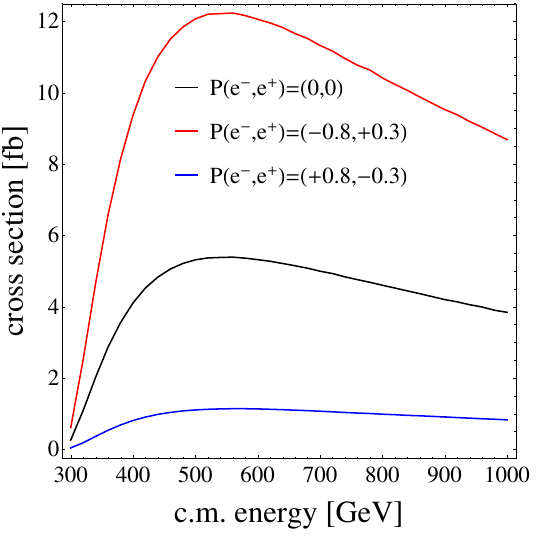
Figure 2 . Cross section of the e + e (cid:0) three choices of beam polarizations: P ( e (cid:0) ; e + ) = (0 ; 0), ( m H = 125